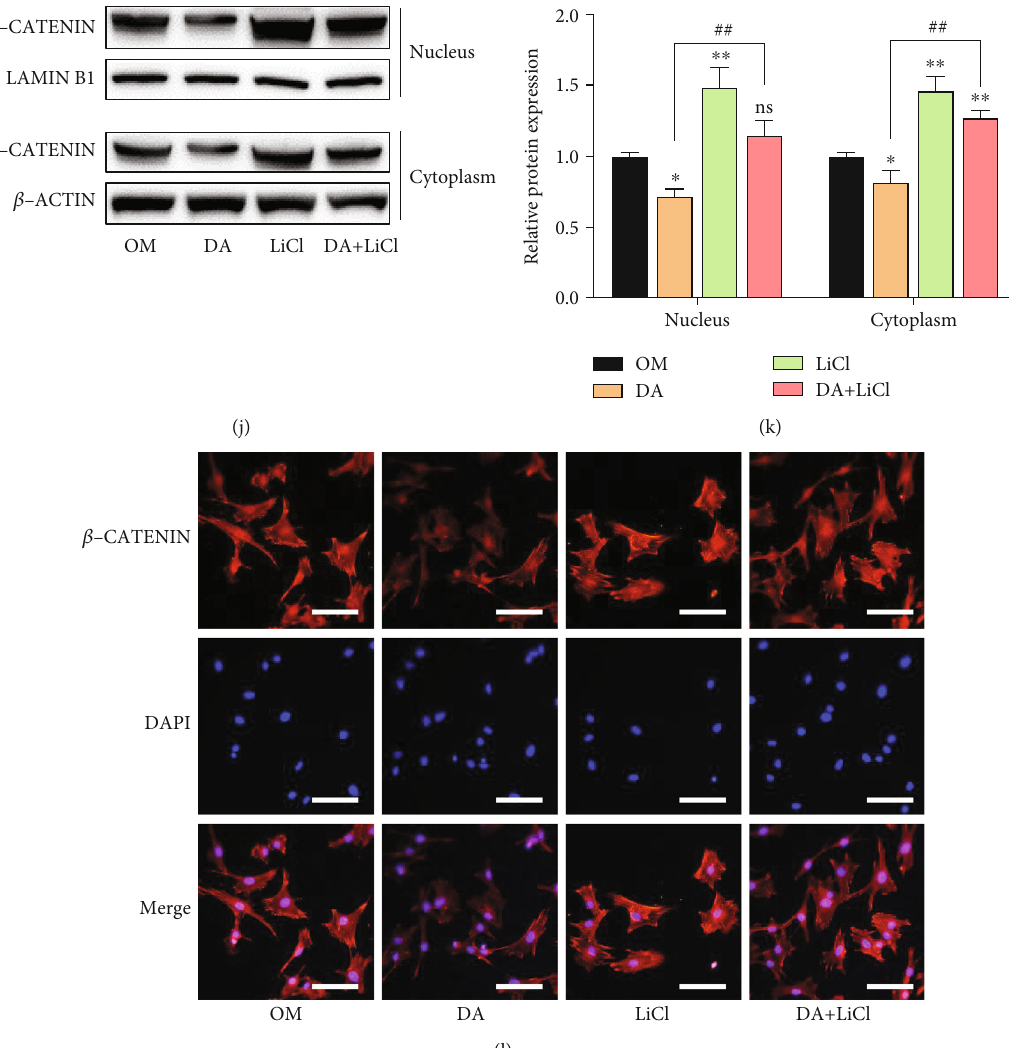
Figure 5: LiCl rescues the attenuation of DA on rBMSC osteogenic di ff erentiation via the AKT/GSK-3 β / β -catenin pathway. rBMSCs were pretreated with 5mM LiCl for 2 h and then cultured in osteogenic medium containing 10 -5 M DA. (a) ALP staining of rBMSCs after 7 days of di ff erentiation. Optical photos (upper photo) and microscopic images (lower photo). (b) ALP activity of rBMSCs measured after 7 days of di ff erentiation. (c) Calcium nodules assessed by Alizarin Red staining after 14 days of di ff erentiation. Optical photos (upper photo) and microscopic images (lower photo). (d) Relative quanti fi cation of Alizarin Red staining. (e) Expressions of Col1a1 , Alp , Runx2 , Opn , and Ocn measured by qRT-PCR assay after 7 days of di ff erentiation. (f, g) Expression of COL1A1, ALP, RUNX2, OPN, and OCN measured by western blot assay after 7 days of di ff erentiation. (h) Expression of GSK-3 β and p-GSK-3 β measured by western blot assay after 24h of di ff erentiation. (i) Quanti fi cation of p-GSK-3 β /GSK-3 β ratio. (j, k) The expression levels of nuclear and cytoplasmic β -CATENIN analyzed by western blot. (j) and quanti fi ed (k) in the indicated groups after 24 h of di ff erentiation. (l) The translocation of β -CATENIN in the nucleus assessed by immuno fl uorescence assay after 24 h of di ff erentiation. β -CATENIN was stained as red and nuclei were stained by DAPI showing blue. Scale bar, 100 μ m. ∗ p < 0 : 05 and ∗∗ p < 0 : 01 compared to OM group; # p < 0 : 05 and ## p < 0 : 01 compared to DA group; ns: no signi fi